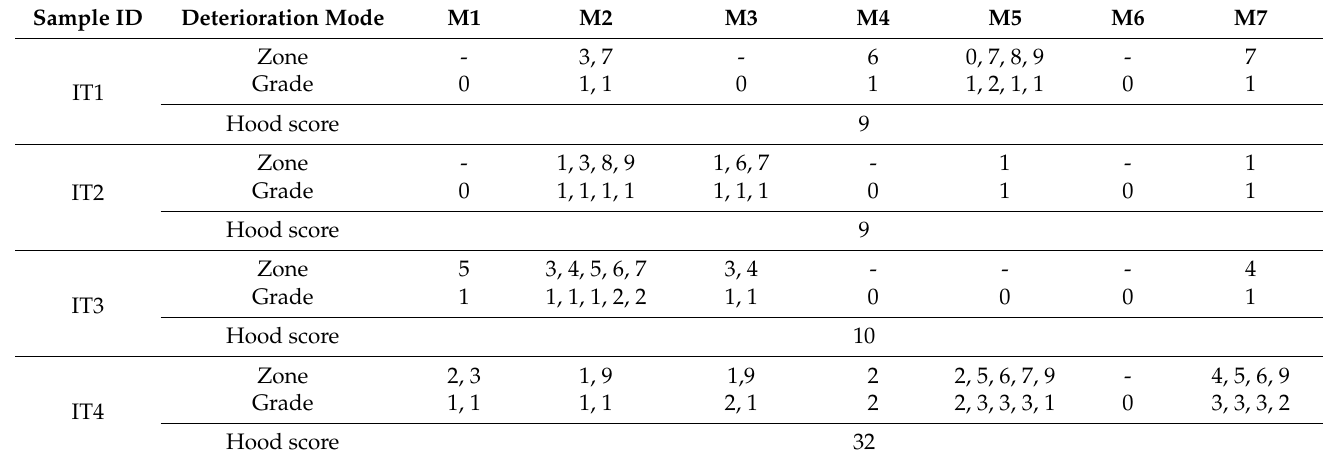
Table 2. Surface deterioration modes and Hood index computation for the retrieved UHMWPE tibial